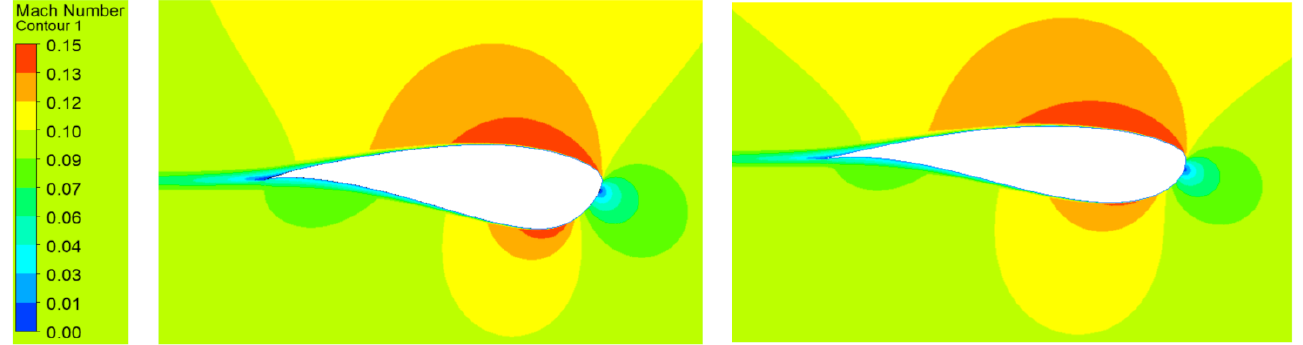
Figure 16. Mach number contour for original ( left ) and the optimized airfoil ( right ) (NREL